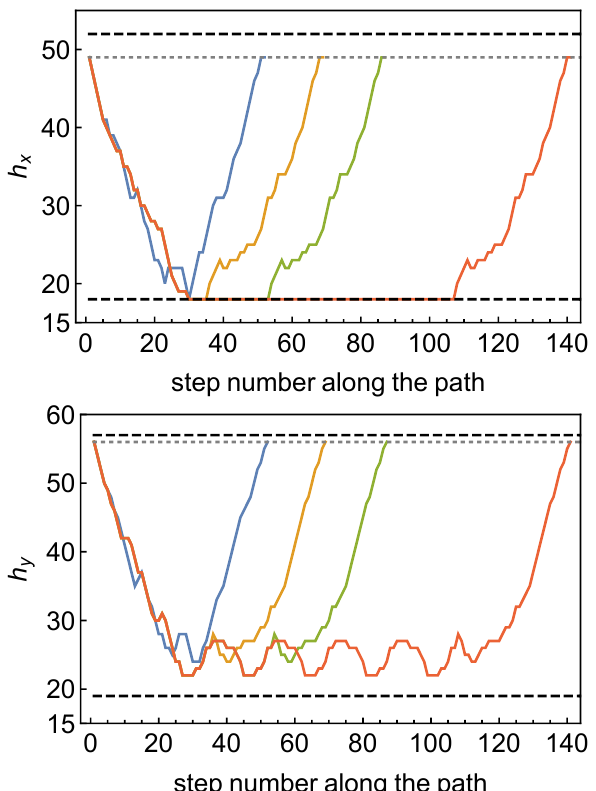
Figure 12. Heights in 2 basic directions of consecutive simplices along loops of winding numbers 1,0,0,0 (blue), 2,0,0,0 (orange), 3,0,0,0 (green), 6,0,0,0 (red) starting from a simplex in an { } { } { } { } outgrowth. The dashed lines indicate the minimal and maximal heights in the configuration, and the dotted line indicates the height of the initial